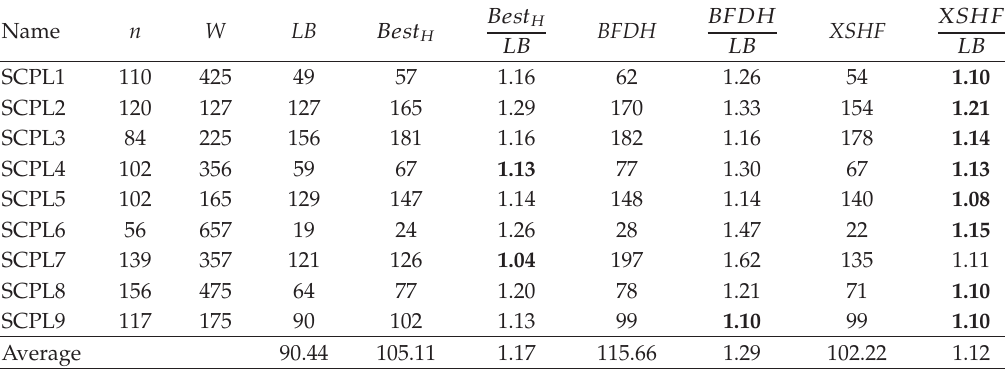
Table 1: Comparison of BSHF and NSHF heuristics and literature